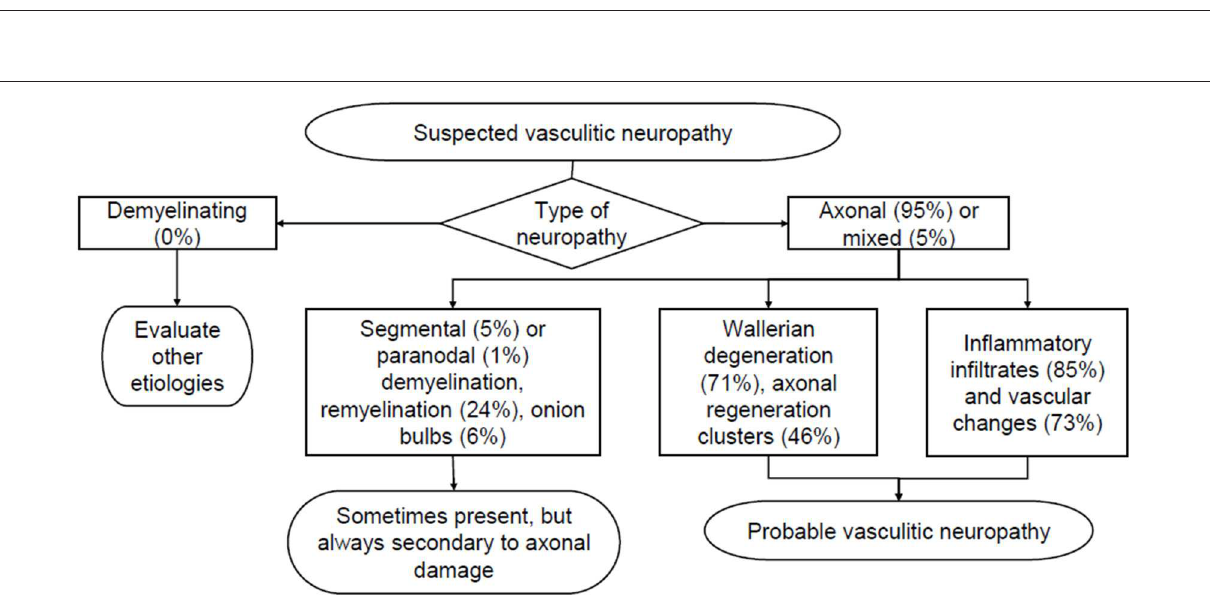
Frontiers in Neurology | www.frontiersin.org